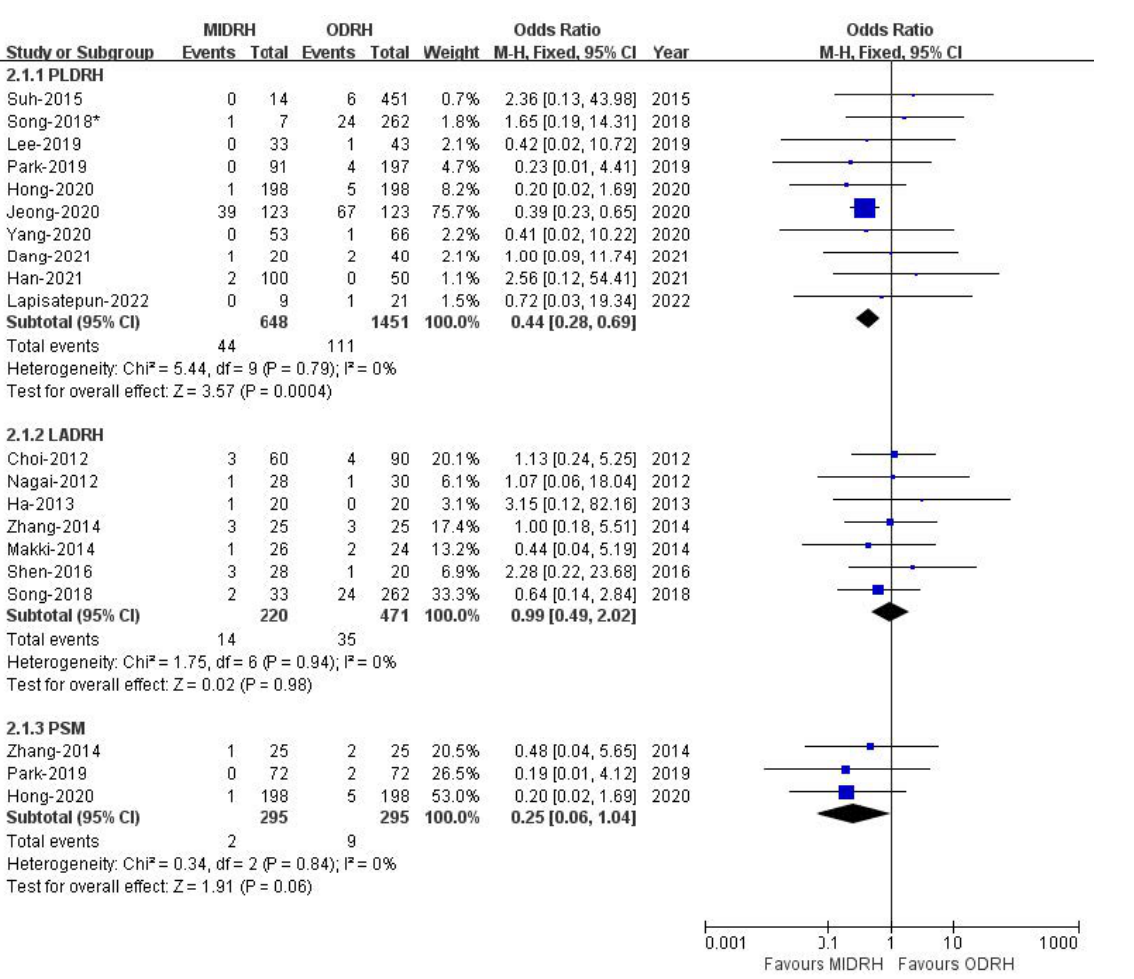
Figure 7. Forest plot comparison of MIDRH versus ODRH for pulmonary complications. * ： Dif-